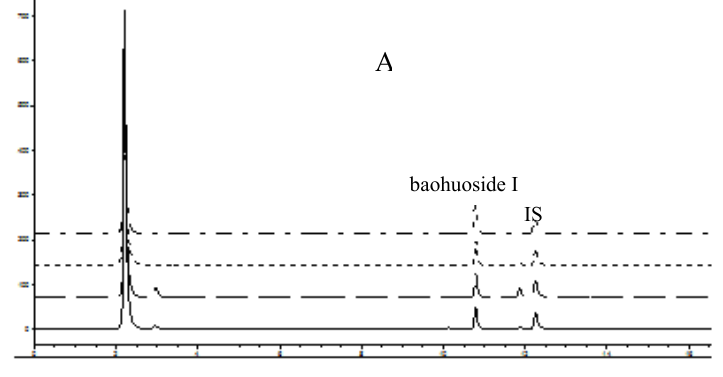
Figure 2. HPLC elution profiles of five prenylflavonoids and their intestinal metabolites as following sequence: duodenum, jejunum, ileum and colon. A(baohuoside I), B(icariin), C(epimedin A), D(epimedin B), E(epimedin C). Testosterone was used as an internal standard (IS).